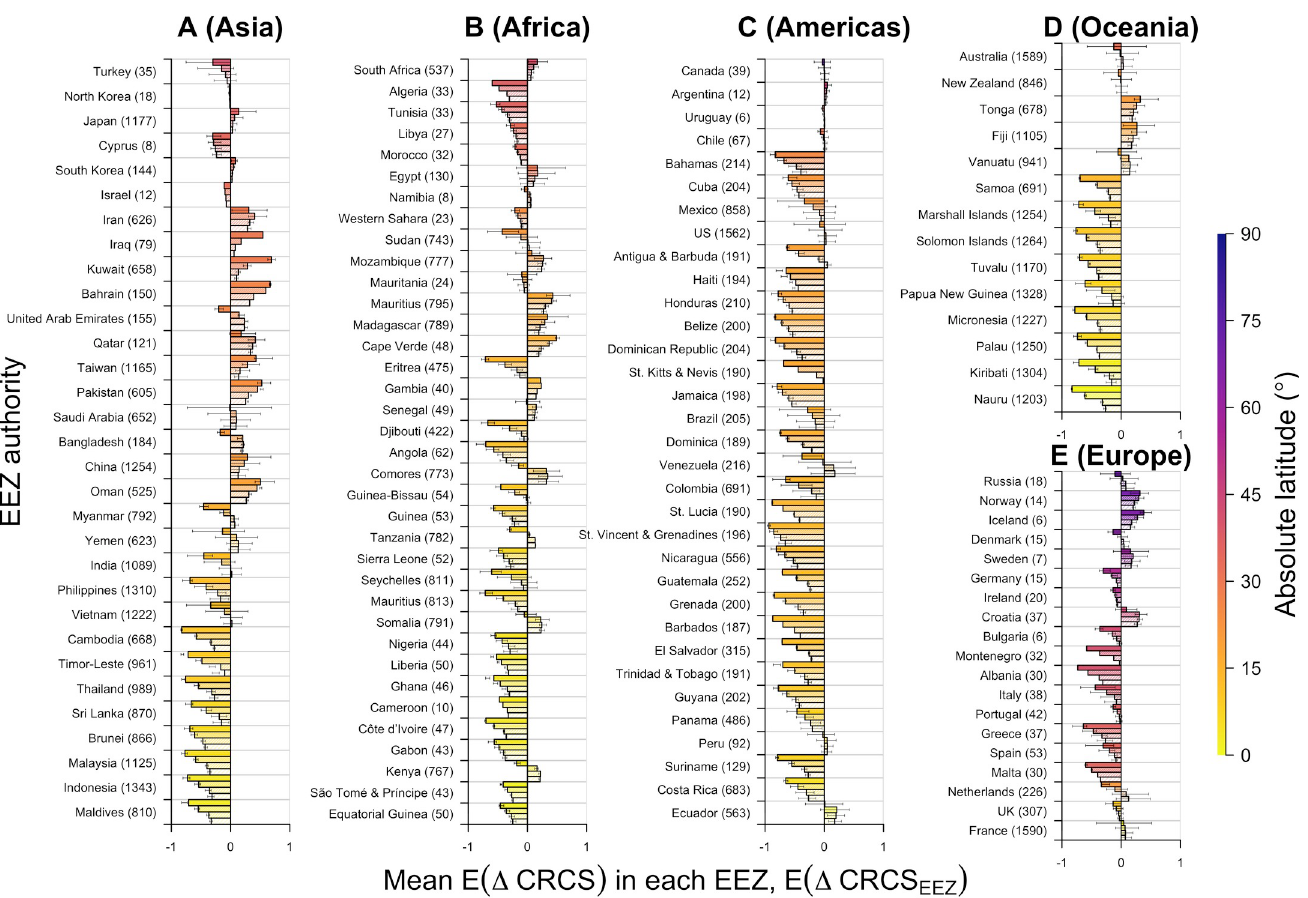
Fig 4. The mean predicted change in the index of thermal habitat suitability (CRCS) under future sea surface temperature change, synthesised across the coastal areas of all Exclusive Economic Zones (EEZs) containing more than five modelled species, in (A) Asia, (B) Africa, (C) the Americas, (D) Oceania and (E) Europe. For each EEZ, four bars are shown, denoting the average change in CRCS across all grid cells in that EEZ (E( Δ CRCS EEZ )), calculated from the mean predicted changes in each grid cell (E( Δ CRCS i,j )), under mid-century RCP 4.5 (bottom bar, lightest hatching) and RCP 8.5 (second bar) and late-century RCP 4.5 (third bar) and RCP 8.5 (top bar, densest hatching) experiments. For each EEZ, the colour of the top bar (the late-century RCP 8.5 experiment) indicates the EEZ’s (absolute) mid-point latitudinal location, which may be influenced by overseas territories. Error bars mark the interquartile range. Numbers in brackets after each EEZ indicate the number of modelled